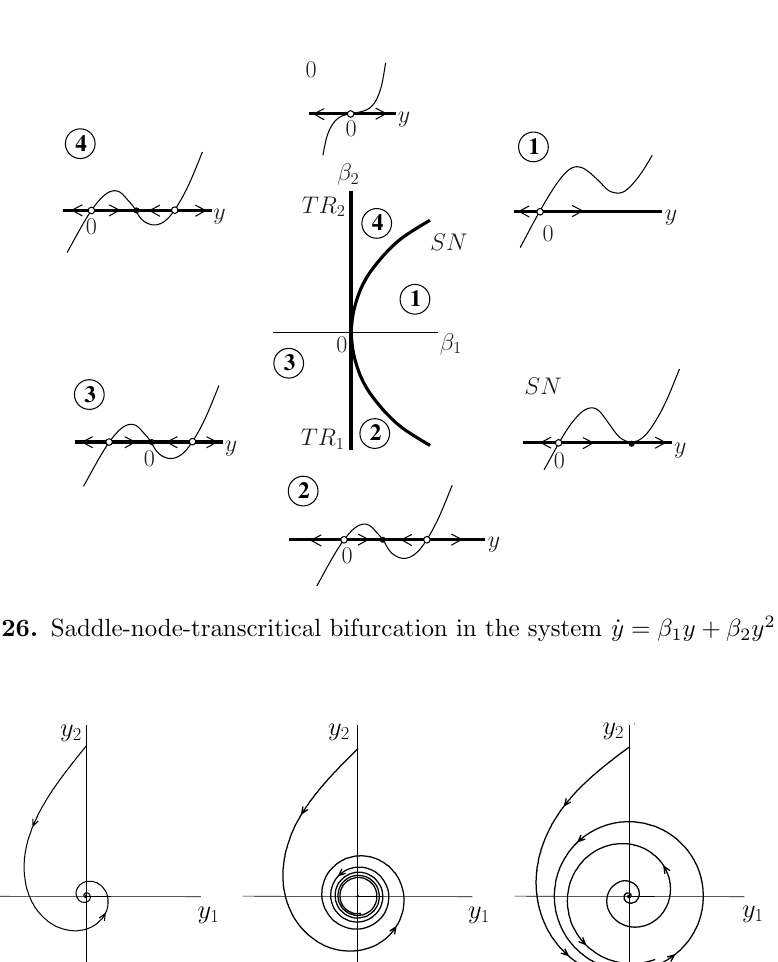
1 = (cid:12)y 1 (cid:0) y 2 (cid:0) y